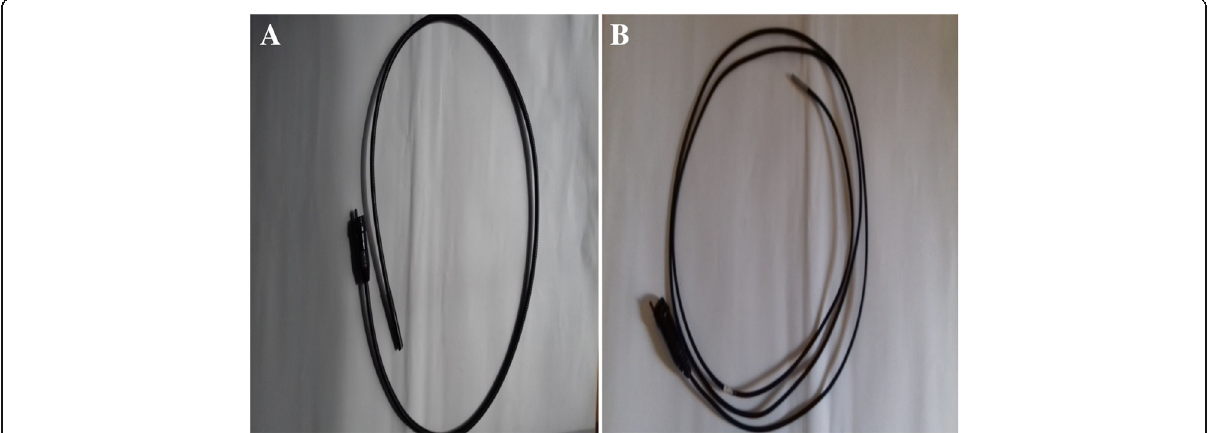
Fig. 1 Photograph showing the semi-flexible ( a ) and flexible cold fibre probe ( b ) used as video laryngoscope during endotracheal intubation in